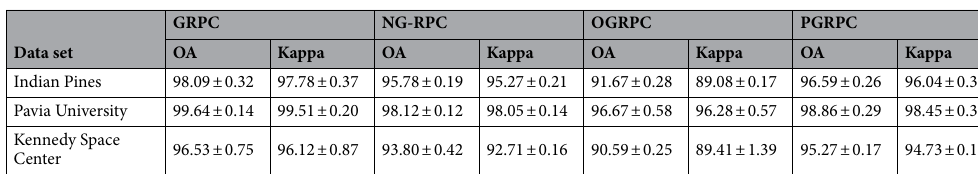
Table 7. The classification results (OA (%) and Kappa (%)) obtained by using GRPC and its three variants.